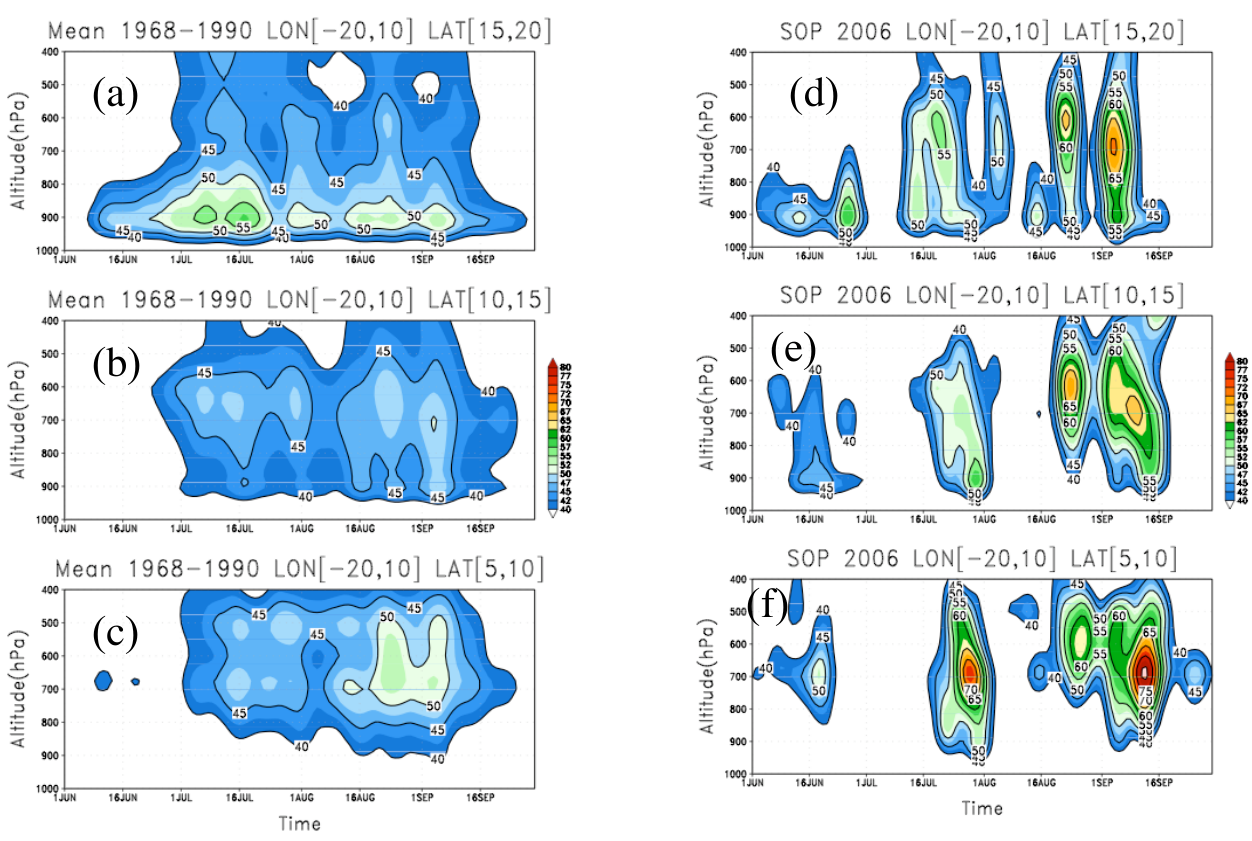
Fig. 18. Vertical and spatial distribution of the mean AEW activity, using wavelet analysis of the daily meridional wind, over the West Africa and near Tropical Atlantic in 3 domains; longitudes 20 ◦ W–10 ◦ E, latitudes 15 ◦ N–20 ◦ N, 10 ◦ N–15 ◦ N and 5 ◦ N–10 ◦ N. Left panels (a, b, c) show the 1968–1990 climatology, right panels (d, e, f) the AMMA summer SOP.